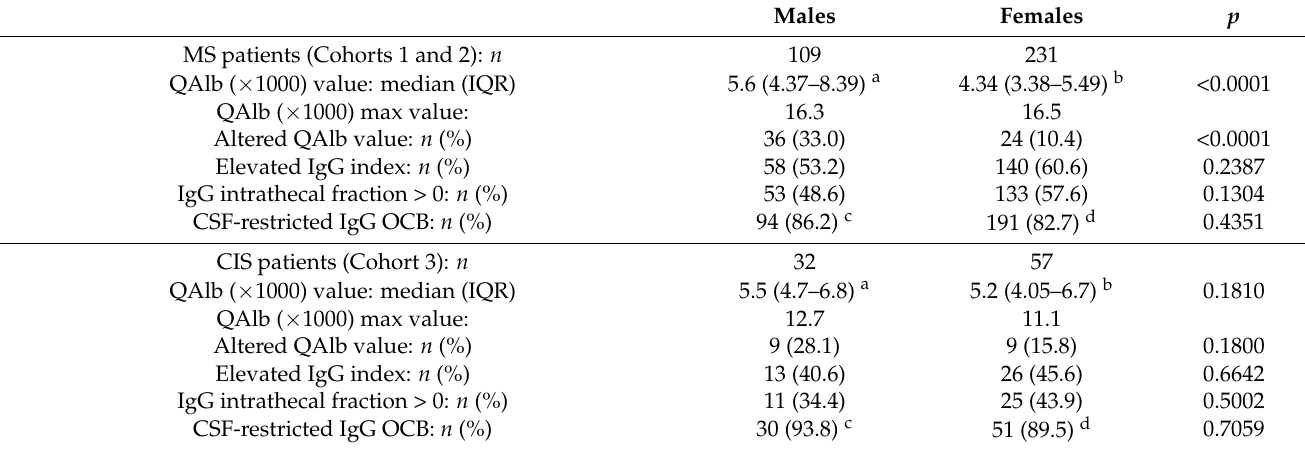
Table 2. Laboratory characteristics of the study population. Cohort 1 and cohort 2 included patients with multiple sclerosis (MS) and were analyzed as a whole, while cohort 3 included patients with the clinically isolated syndrome